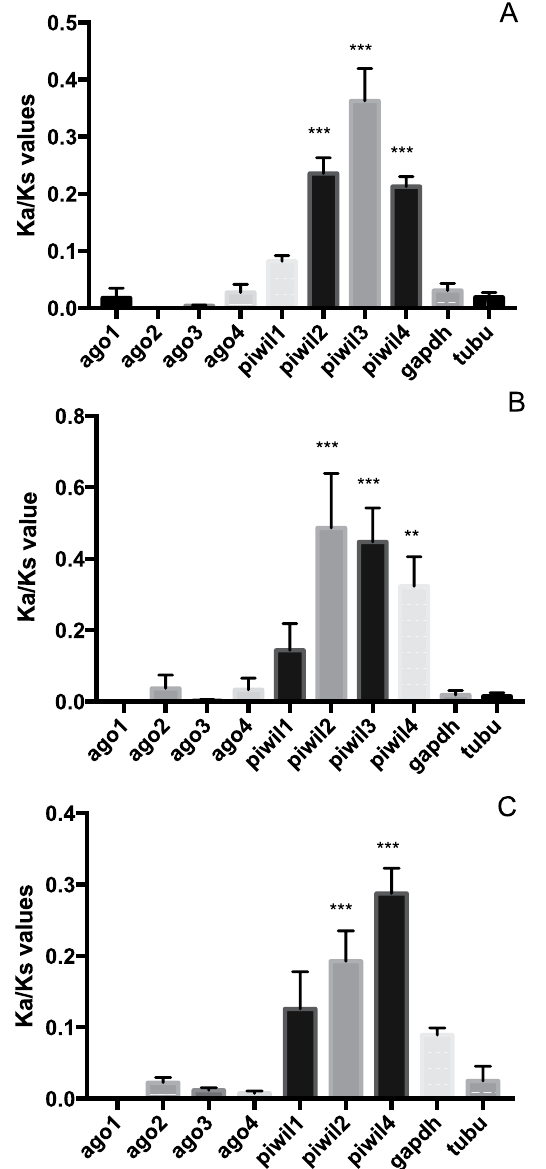
Figure 4. The evolutionary rate of argonaute sequences within the primates, determined by means of pairwise (Fig. 4A) and ML-tree based comparison (Fig. 4B). The nucleic acid sequence of Argonautes of Homo sapiens , Pan troglodytes , Pan paniscus , Gorilla gorilla , Pongo abelli , Macaca mulatta and Callithrix jacchus were used for Ka/Ks estimations. Figure 4C: Rate of molecular evolution of Argonautes within vertebrates. Ka/Ks values are estimated by means of ML-tree based comparison and by using sequence information of H. sapiens , Mus musculus , Alligator mississippiensis , Gallus gallus and Danio rerio . Noteworthy, Piwil4 is absent in the G. gallus and D. rerio genome sequence. The bars represent the mean + / − SEM of individual Ka/Ks values per gene. Statistics (MWU-test) support difference with the housekeeping genes glyceraldehyde 3-phosphate dehydrogenase (gapdh) and apha-tubulin1a (tubu); ** p < 0.01, *** p <